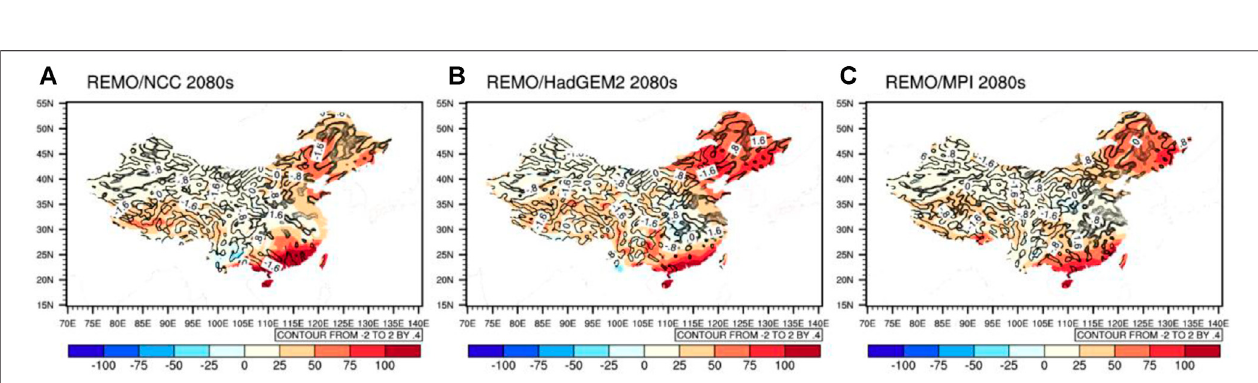
FIGURE 11 | The changes in the water vapor fl ux and the water vapor fl ux divergence at 850 hPa in the future period of 2066 – 2095 relative to the historical period from the downscaling simulations driven by different GCMs.